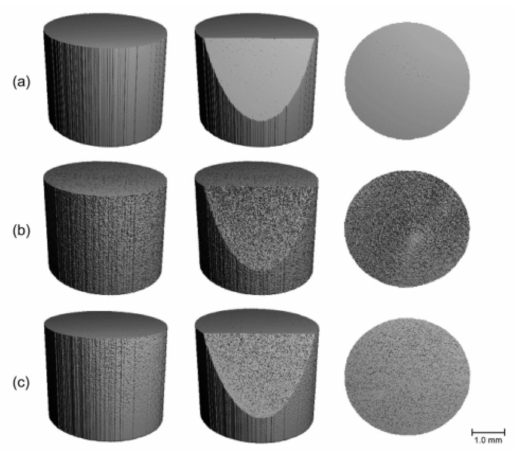
Figure 2. µ CT images of Ni–Cr–Mo alloys: LWC ( a ), SLM ( b ), and SMM ( c ). Cylindrical-shaped 3D images (left), cylindrical-shaped images with cut planes (middle), and top images of cylinders (right).